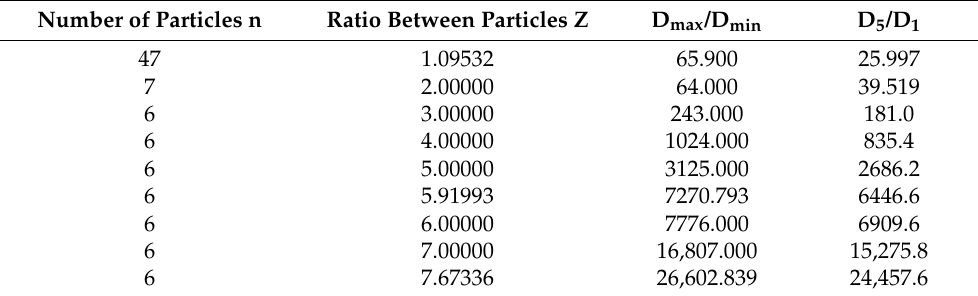
Table 10. Practical limits of the ratio of the maximum diameter/minimum diameter particles in a particle size